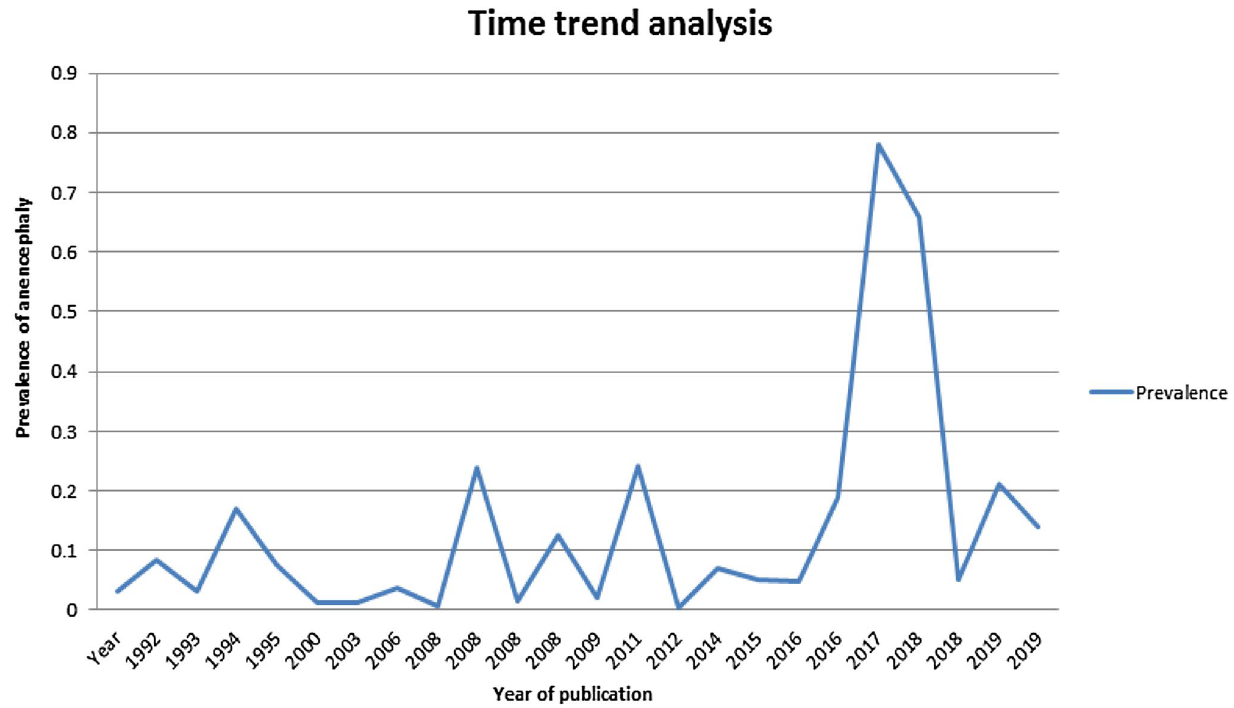
Figure 6. Time trend analysis of the prevalence of anencephaly in relation to publication year in Africa,